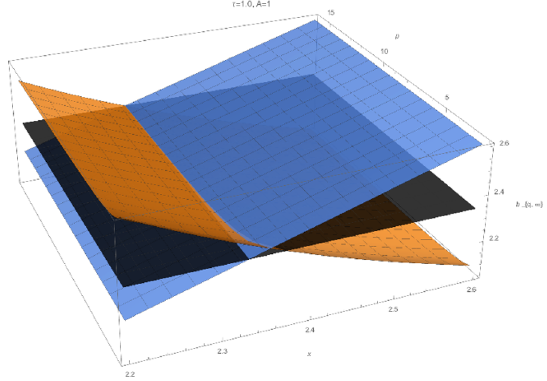
Figure 12 . Plot of b q, ∞ as a function of p , at A = 1 and τ = 1 . 0 . The blue surface is the function x on the left-hand side of (A.1). The orange surface is the right-hand side of (A.1) as a function of p and x . b q, ∞ is determined by the intersection of these two surfaces. The black horizontal surface is the asymptotic value b ∞